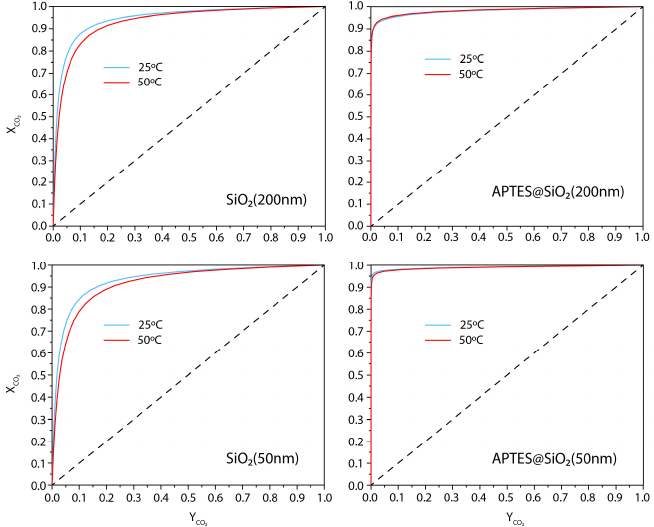
Figure 14. Prediction of the equilibrium composition of the adsorbed phase ( x CO2 ) as a function of the CO 2 mole fraction in the gas phase ( y CO2 ) in CO 2 /N 2 mixtures at 750 mmHg and at 25 and 50 °C. This conclusion is corroborated by the expected amount of adsorbed moles deter- mined with Equations (7) and (8) from the mole fractions predicted by IAST (Figure 14). The predicted adsorbed amount of both gases as function of the CO 2 mole fraction in the phase gas at 750 mmHg and both temperatures are plotted in Figure S4. The amount of N 2 adsorbed on non-functionalized SiO 2 nanoparticles from diluted mixtures (i.e., CO 2 molar fractions, y CO < 0.2), although very small, is not negligible and therefore the separation of 2 both gases will not be entirely effective. On the other hand, in the case of the functionalized samples, the amount of N 2 adsorbed is negligible compared to the amount of CO 2 adsorbed at any mole fraction in the gas phase. Therefore, a good separation of both gases could be carried out with these